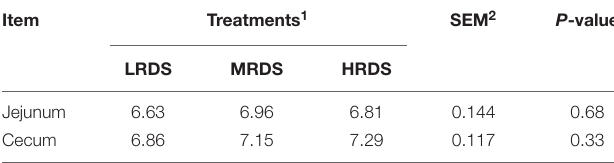
TABLE 1 | Effect of dietary RDS on hindgut SCFAs concentration. TABLE 2 | Effect of dietary RDS on intestinal pH